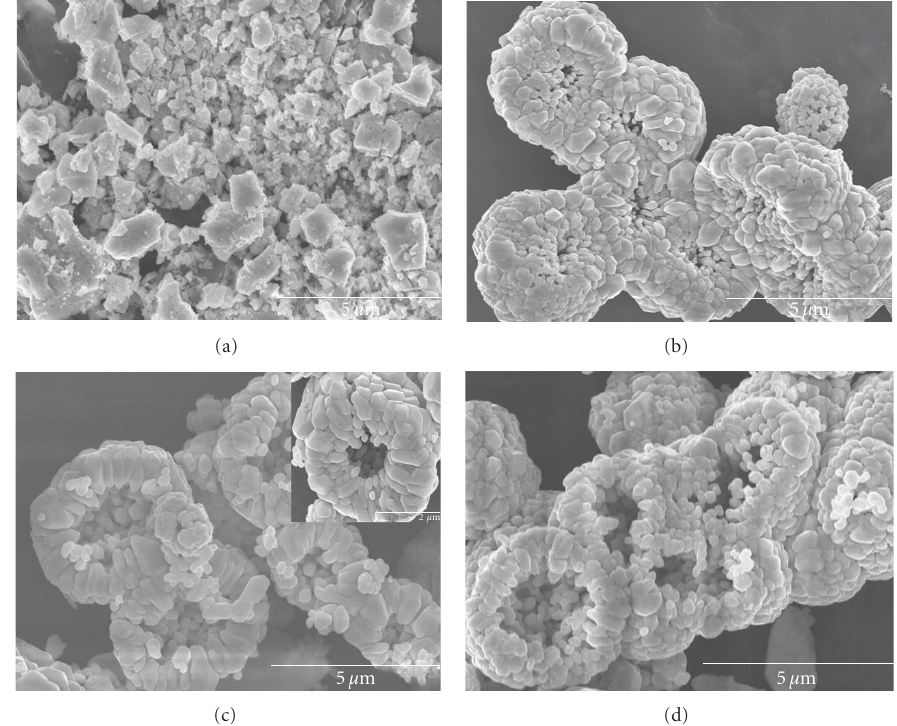
Figure 3: SEM images of BiVO 4 samples prepared with di ff erent amount of urea ranging from 0 (a), 3 (b), 6 (c) to 9 g (d) at 180 ◦ C for 24 h.